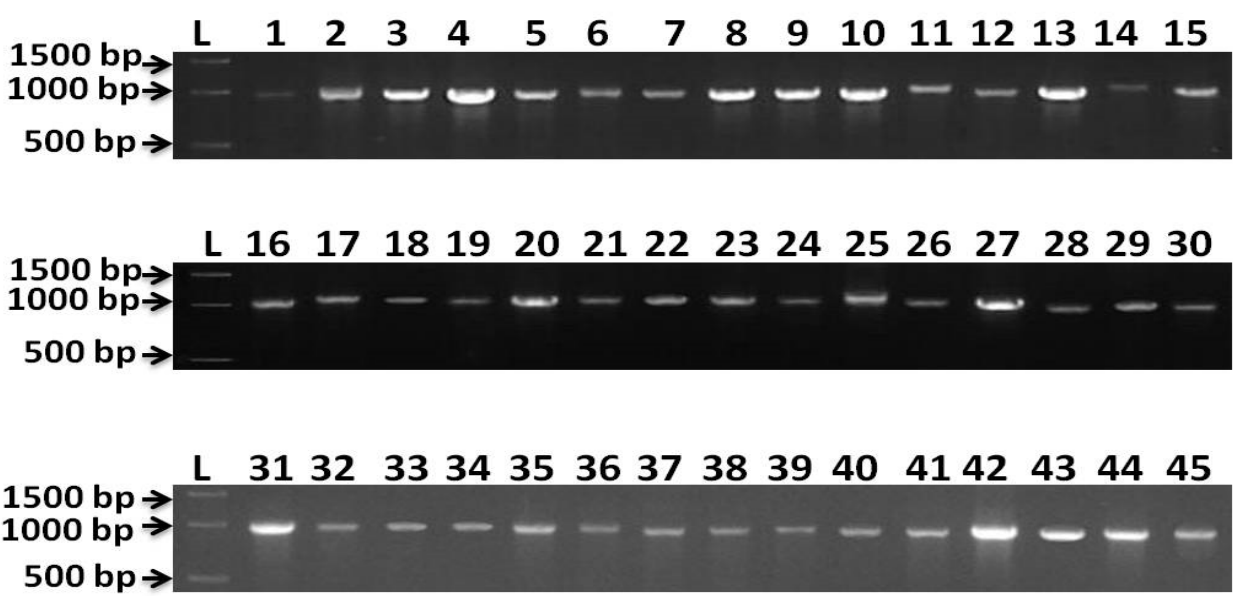
Figure 5. Representative bands of PCR product from β -tubulin gene. Amplification fragment size 1000 base pairs (bp). L = 1kb ladder, 1 = BhEt1, 2 = BhEt2, 3 = BhEt3, 4 = BhEt4, 5 = BhEt5, 6 = BhEt6, 7 = BhEt7, 8 = BhEt8, 9 = BhEt9, 10 = BeEt1, 11 = BeEt2, 12 = BeEt3, 13 = BeEt4, 14 = BeEt5, 15 = BeEt6, 16 = BeEt7, 17 = BeEt8, 18 = BeEt9, 19 = KhEt1, 20 = KhEt2, 21 = KhEt3, 22 = KhEt4, 23 = KhEt5, 24 = KhEt6, 25 = KhEt7, 26 = KhEt8, 27 = KhEt9, 28 = KaEt1, 29 = KaEt2, 30 = KaEt3, 31 = KaEt4, 32 = KaEt5, 33 = KaEt6, 34 = KaEt7, 35 = KaEt8, 36 = KaEt9, 37 = SaEt1, 38 = SaEt2, 39 = SaEt3, 40 = SaEt4, 41 = SaEt5, 42 = SaEt6, 43 = SaEt7, 44 = SaEt8, 45 = SaEt9.